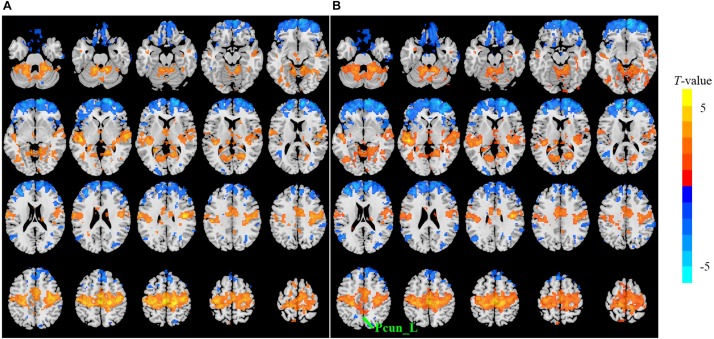
The t map (p < 0.05, cluster size ≥ 10 voxels) of eyes closed (EC) versus eyes open (EO) in Slow-6 (0–0.0117 Hz) by FFT-ALFF (A) and db2-ALFF (B), respectively. Warm colors indicate higher ALFF in EC conditions. ALFF, amplitude of low-frequency fluctuation; FFT, fast Fourier transform; Pcun_L, left precuneus.